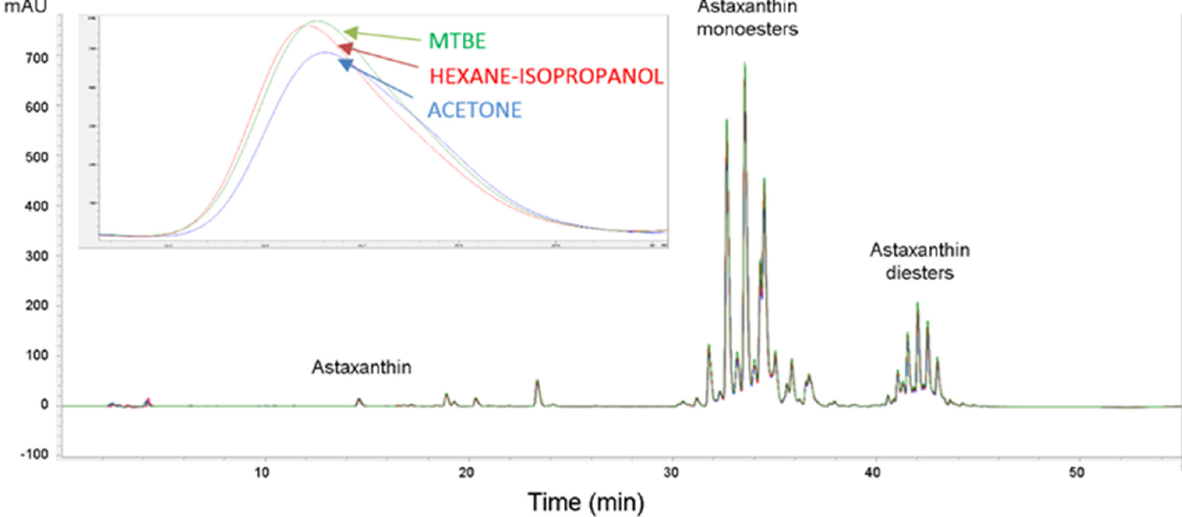
Figure 2. HPLC chromatogram (DAD, 475 nm) astaxanthin, mono − and diesters in three different solvents (MTBE: methyl tert- butyl ether, HEX-IPA: hexane-isopropanol; ACE: acetone). The inserted picture shows the enlarged free astaxanthin chromatogram. Solvents MTBE and HEX-IPA extracted a significantly higher amount of free astaxanthin.